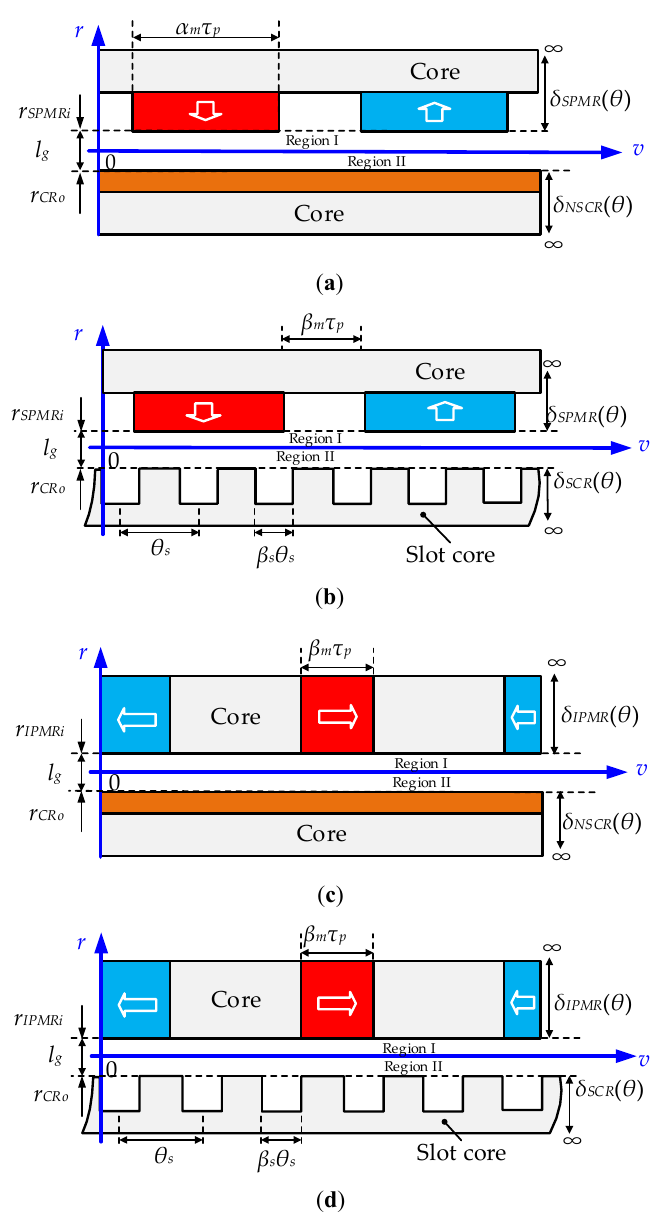
Figure 4. The permeance models of the four typical PMECCs: ( a ) Model − A; ( b ) Model − B; ( c ) Model − C; ( d ) Model − D.